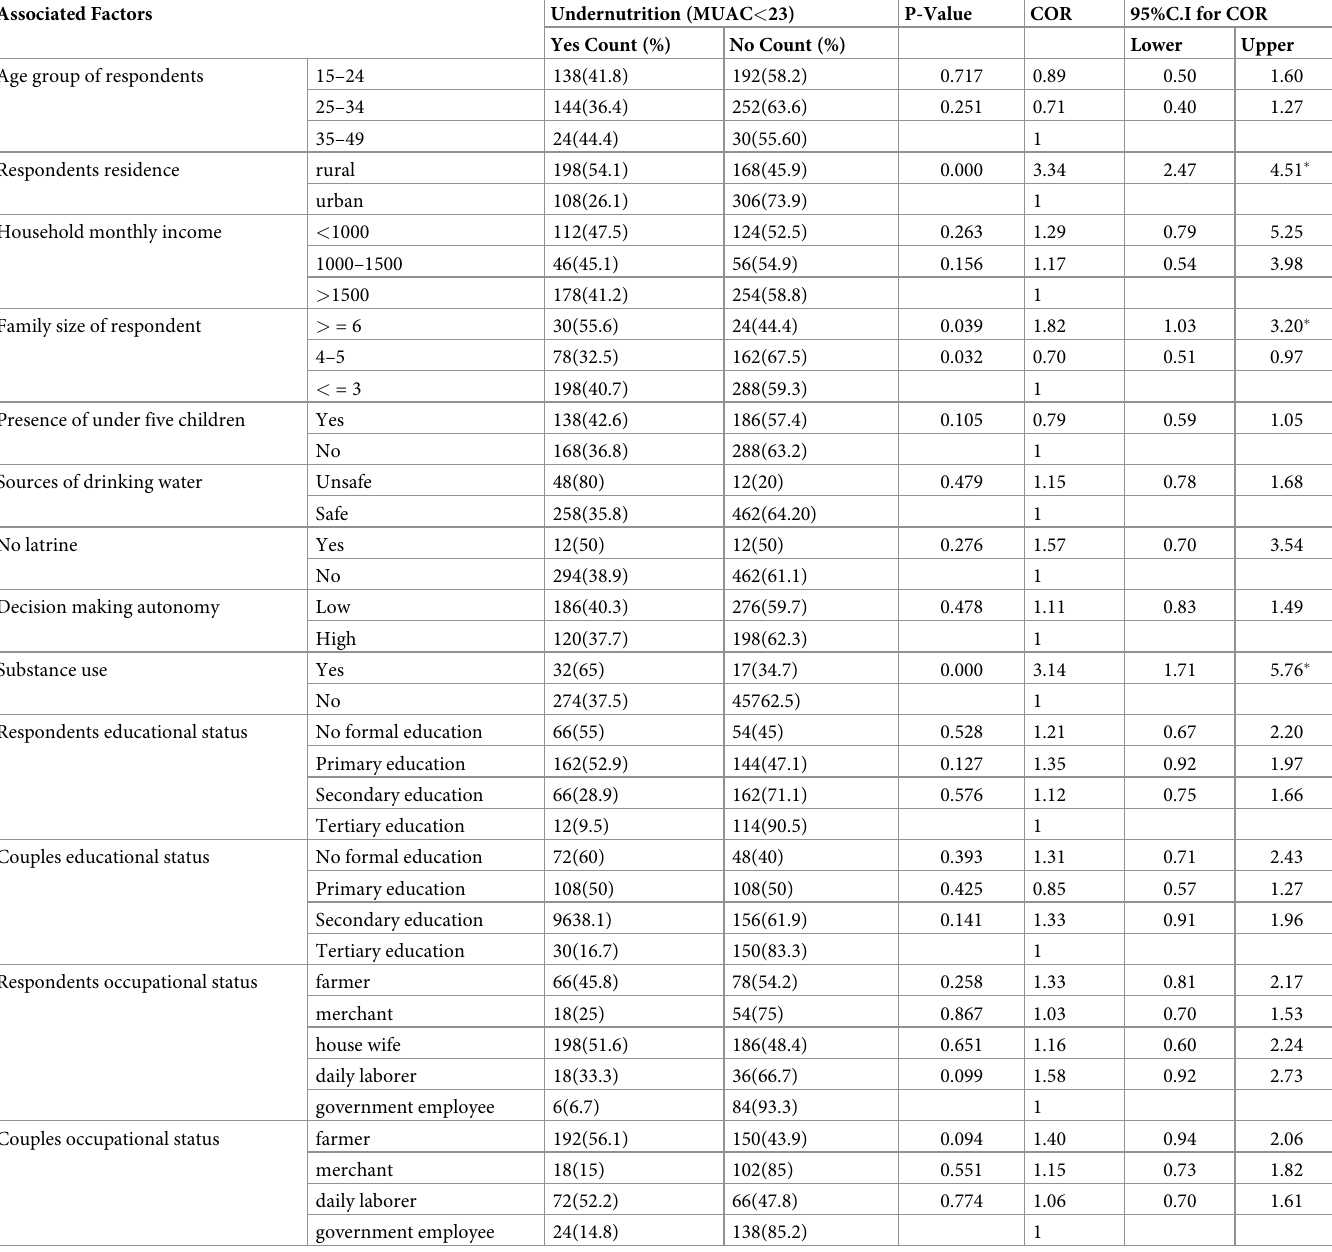
Table 5. Bivariate analysis of socio demographic factors associated with under nutrition among pregnant women attending ANC at West Wollega public hospitals, 2020. Associated